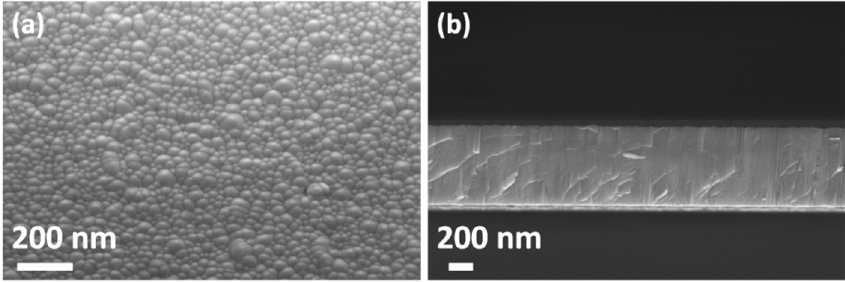
Figure 2. FESEM images showing ( a ) the surface morphology and ( b ) the cross-section structure of ZnO thin films grown on Au-coated Si substrates.